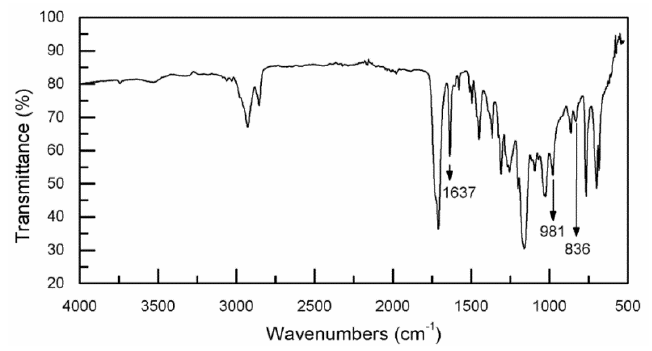
Figure 3. Infrared spectrum of AESO-EC (1:1) thermoset.